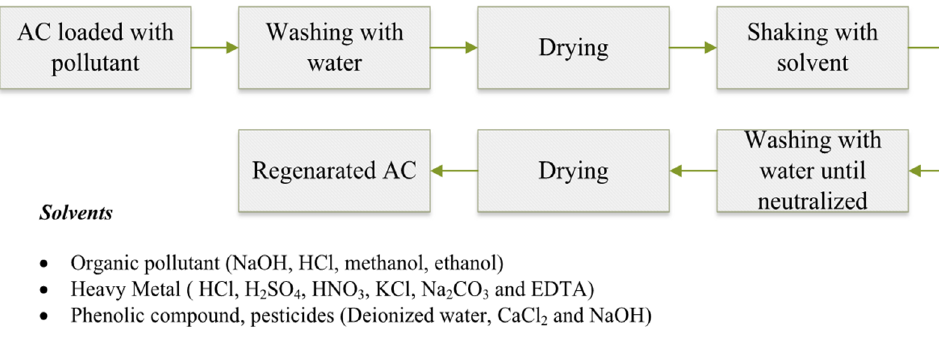
Figure 6. A schematic on the desorption of solute and regeneration of AC.